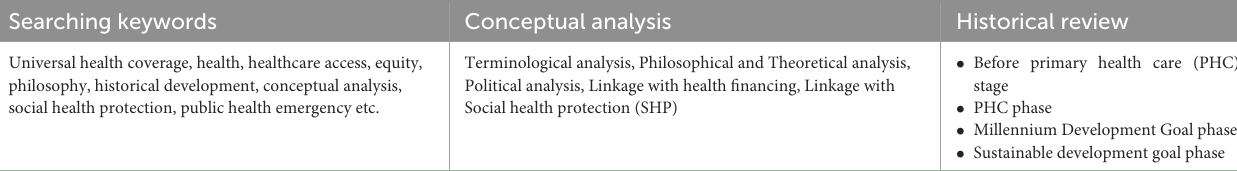
TABLE 1 Review approach, conceptual, and historical analysis